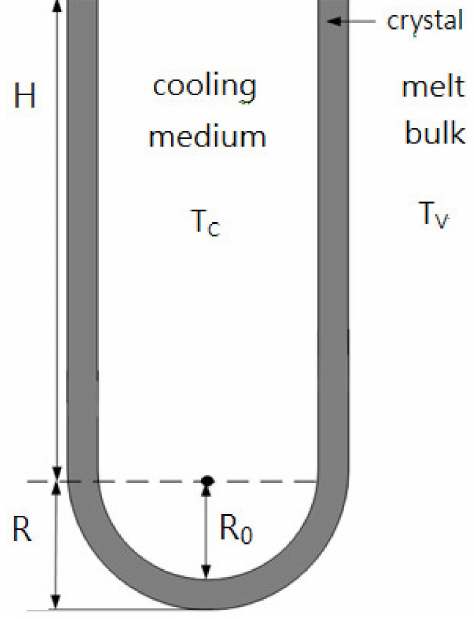
Figure 3. Schematic diagram of the crystal layer grown on the outer surface of the cylindrical crystallizer (R 0 = 0.01 m and H = 0.10 m), where the dark area represents the crystal layer